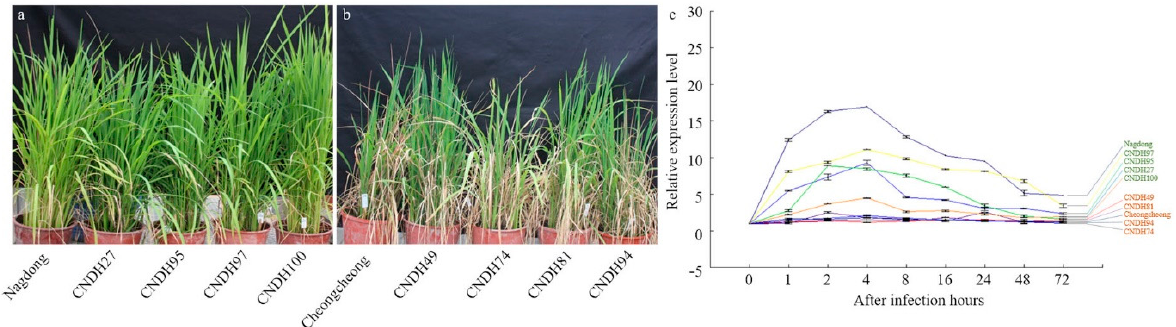
Figure 5. Quantitative RT-PCR analysis of the OsWRKYq6 gene in high-resistance and weak-resistance varieties in the Cheongcheong/Nagdong double haploid (CNDH) population. ( a ) five groups (Nagdong, CNDH-27, CNDH-95, CNDH-97, and CNDH-100) of highly resistant populations selected from the field; ( b ) five groups (Cheongcheong, CNDH-49, CNDH-74, CNDH-81, and CNDH-94) of susceptible populations selected from the field. ( c ) quantitative RT-PCR analysis results of the defense gene, OsWRKYq6 , in the resistant and susceptible groups in the CNDH population.